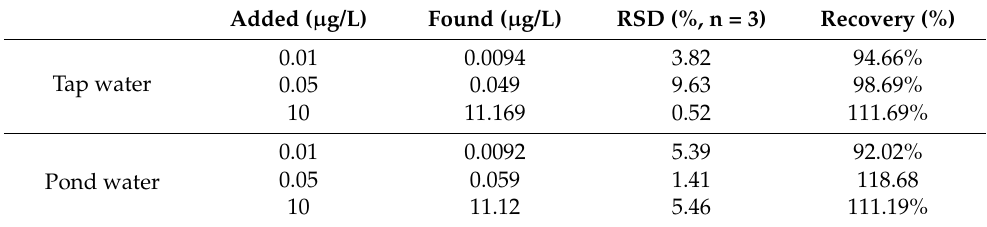
Table 2. Analysis of actual water